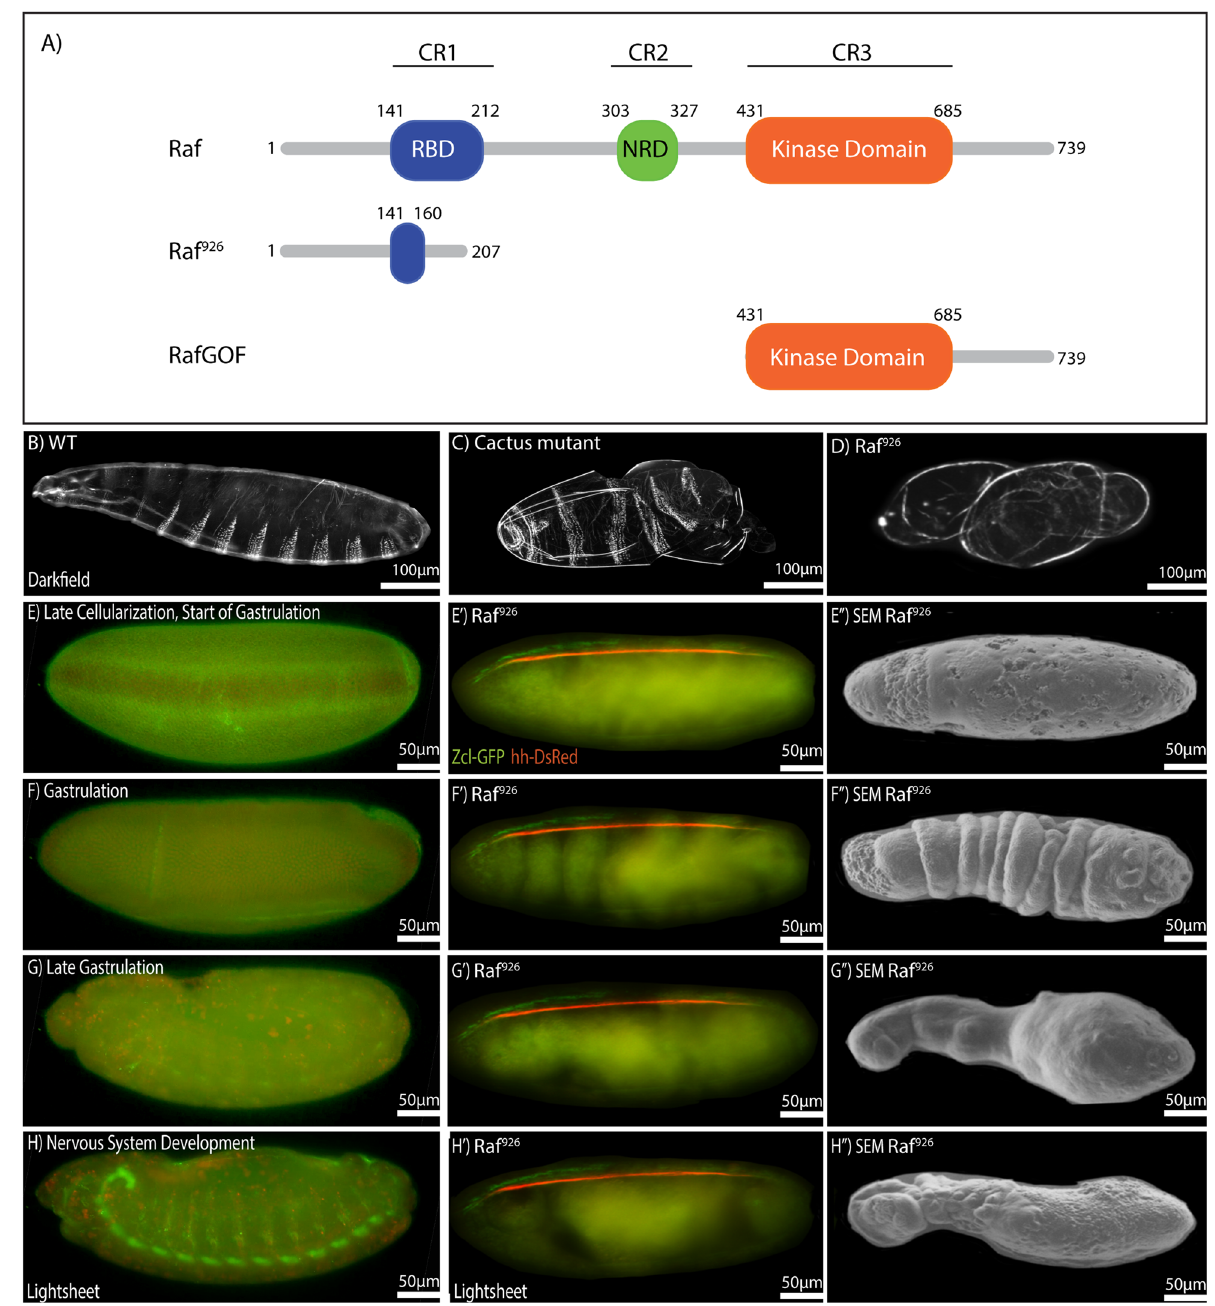
Figure 1. Schematic illustration, cuticular phenotype and developmental progression of Raf 926 mutant embryo. ( A ) Domain organization of Drosophila Raf, Raf 926 and Raf GOF . Raf protein contains the Ras-binding domain (RBD) in conserved region 1 (CR1), negative regulatory domain (NRD) in CR2 and protein kinase domain in CR3, with a total length of 739 amino acids. Raf 926 comprised of an altered RBD with 207 amino acids in total due to a deletion of 17 nucleotides which resulted in a frameshift and premature stop codon. Raf GOF contains the kinase domain only, with total length of 309 amino acids. Dark field micrographs of the cuticles of wild type embryo showing normal distribution of ventral denticles and dorsal hair ( B ), a cactus 1 mutant embryo showing strongly ventralized phenotype with ventral denticles expression among the dorsal hair ( C ) and Raf 926 mutant embryo showing a strongly dorsalized phenotype with elongated, tube-like, twisted body entirely covered by dorsal hair ( D ). ( E – H ) Still images of developmental stages of a wild-type embryo to be compared to still images of developmental stages of Raf 926 embryo from lightsheet ( E ′ – H ′ ) and scanning electron microscope (SEM) ( E ″ – H ″ ). Raf 926 embryos develop normally up to cellularization stage. Defective gastrulation is characterized by frequent twisting, elongation of twisted segments, fusions of segments into three main sacs, followed by tissue death. Embryo was visualised with Utrophin-GFP and Histone-RFP, with anterior to the left. Stills were extracted from Video